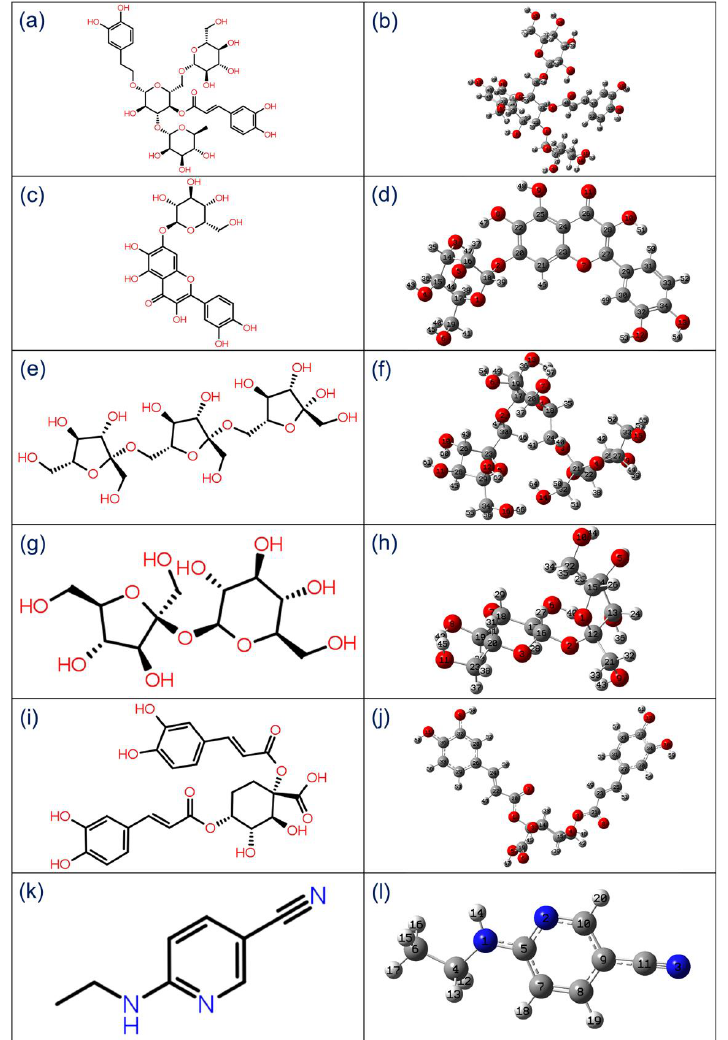
Figure 2. 2D structures and 3D optimized molecular geometries of natural products, viz. ( a , b ) Echinacoside, ( c , d ) Quercetagetin 7-glucoside, ( e , f ) Levan N, ( g , h ) Inulin from chicory, ( i , j ) 1,3- Dicaffeoylquinic acid, and (k-l ) 6-(ethylamino) pyridine-3-carbonitrile as reference compound, were calculated using DFT/B3LYP/6-31G(d,p) level.